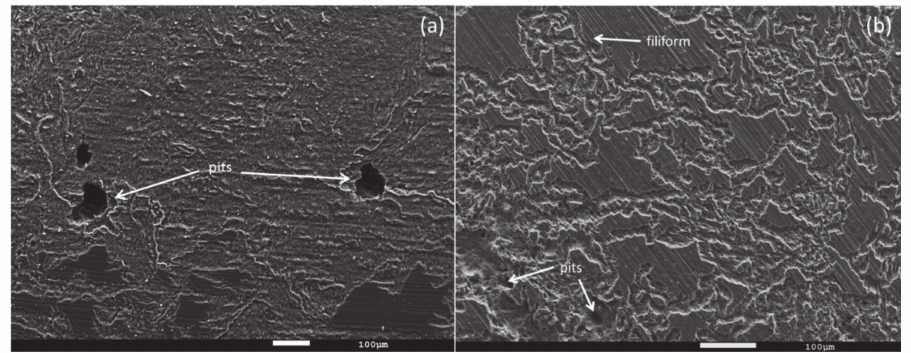
Figure 6. Corrosion morphology of ( a ) Pure Mg and ( b )